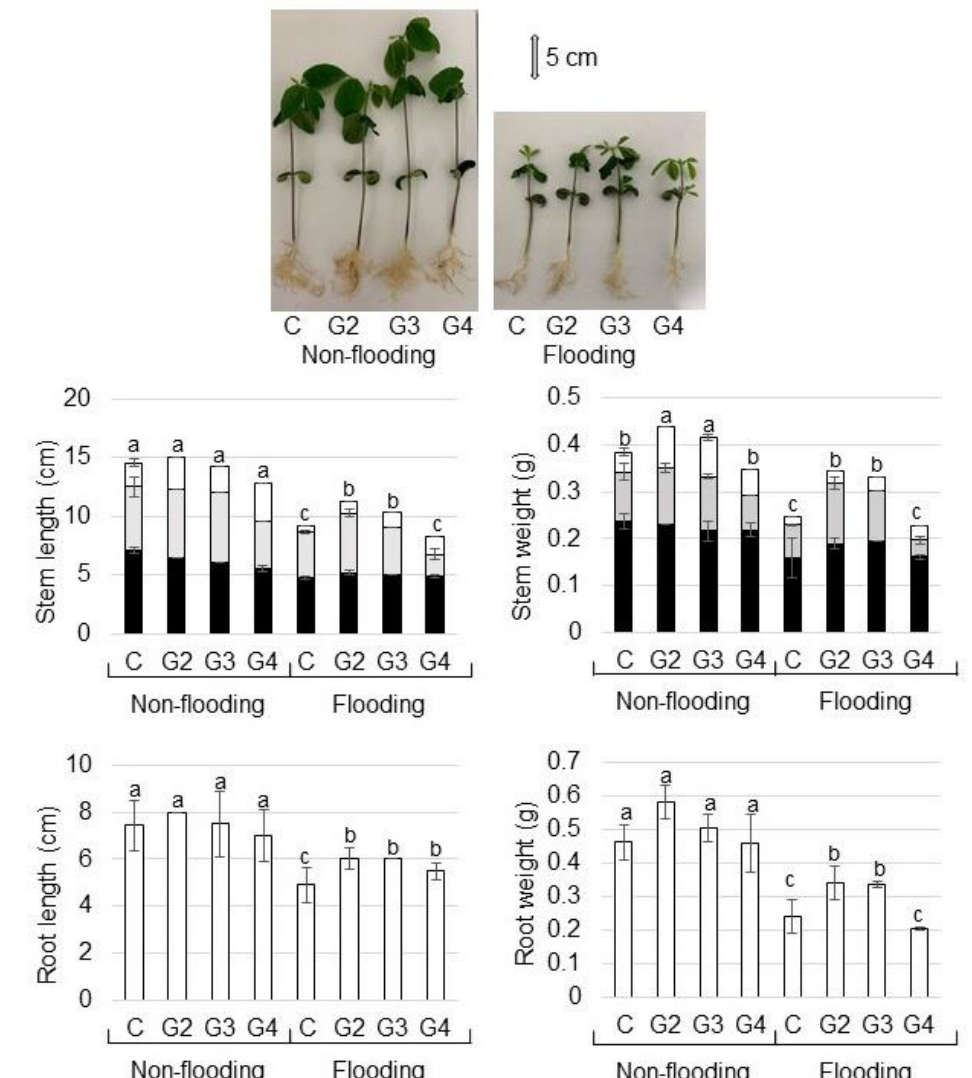
Figure 2. Morphological effect of flooding stress in mutant soybean. Wild type (C) and mutant lines, which are 1386-6 (G2), 1386-9 (G3), 1387-12 (G4), were used. Two-day-old soybeans were flooded for 5 days and water was removed. After 6 days of water removal, root and hypocotyl were collected. For non-flooded group, samples were collected at 13 days after sowing. Photograph shows 13-day-old soybeans. Hypocotyl (black column)/epicotyl (gray column)/2nd internode (white column) length, main root length, hypocotyl/epicotyl/2nd internode weight, and total root weight were measured as morphological parameters. In the graph, hypocotyl/epicotyl/2nd internode was summarized as stem. Data are shown as means ± SD from 3 independent biological replicates. The different letters indicate significant changes according to one-way ANOVA followed by Tukey’s multiple comparisons ( p < 0.05).